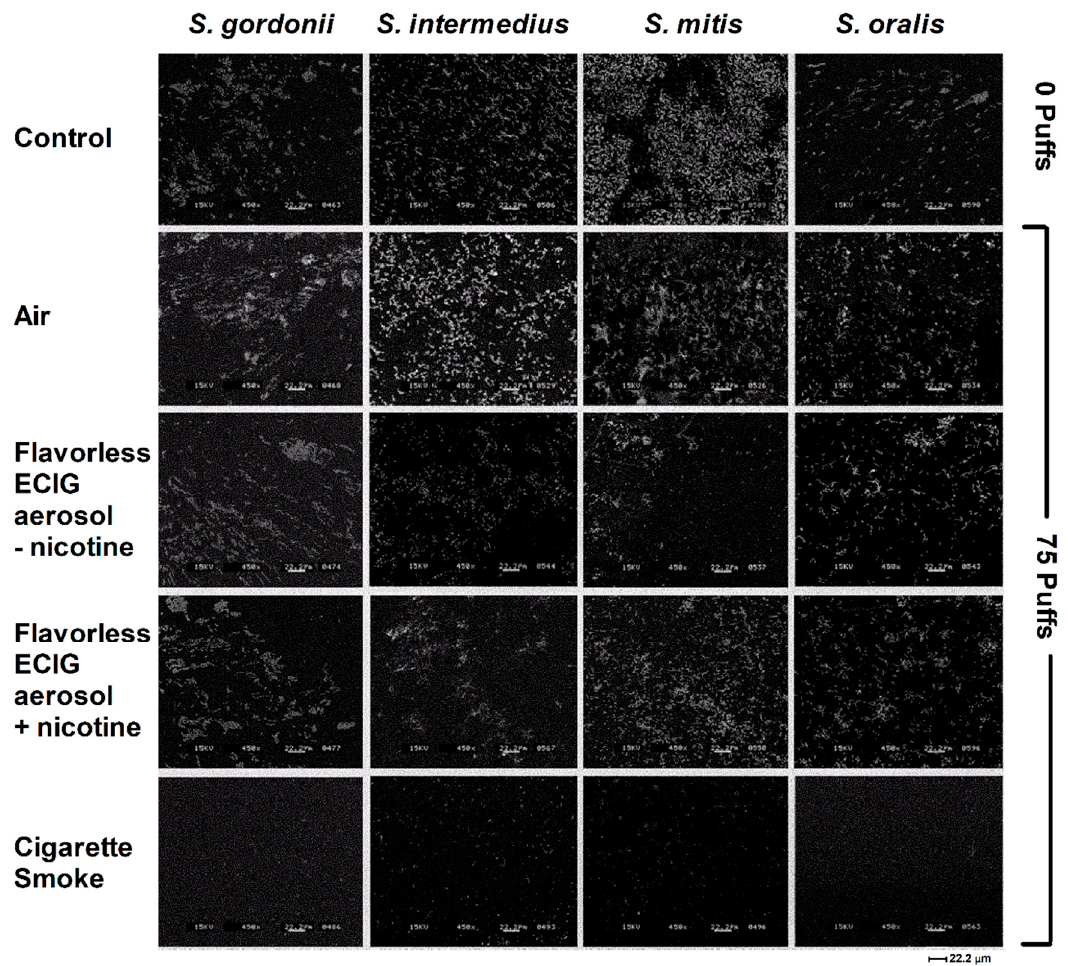
Figure 5. E ff ect of air, flavorless ECIG aerosol ( ± 20 mg / mL nicotine), or smoke (Marlboro ® Red cigarette) on biofilm formation. Representative images of biofilm formation for commensal oral streptococci following exposure to 0 pu ff s of air (control) or 75 pu ff s of air (control), aerosol ( ± 20 mg / mL nicotine) and smoke (Marlboro ® Red cigarette). All images were acquired at 450 × using an acceleration